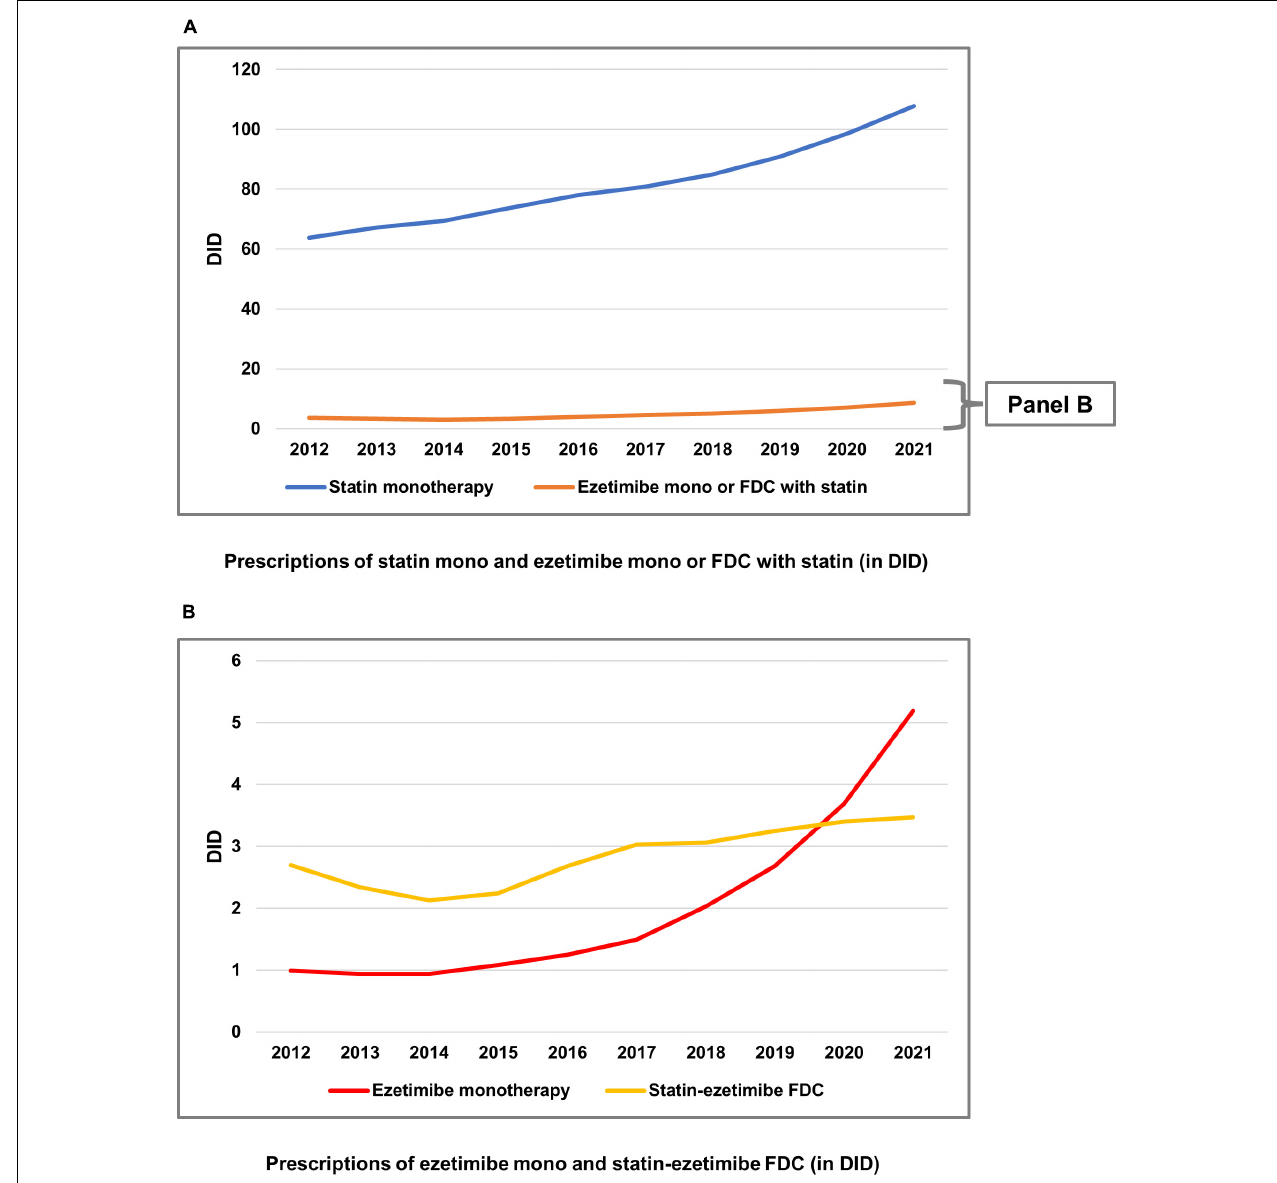
FIGURE 1 | Prescriptions of statins and ezetimibe 2012–2021 in defined daily doses per 1,000 persons insured by statutory health insurance per day (DID). (A) Prescriptions of statin monotherapy and ezetimibe monotherapy or fixed-dose combinations (FDC) with statin (in DID). (B) Prescriptions of ezetimibe monotherapy and statin-ezetimibe FDC (in DID). DID, defined daily doses per 1,000 statutory health insurance-insured persons per day; FDC, fixed-dose combinations; mono: